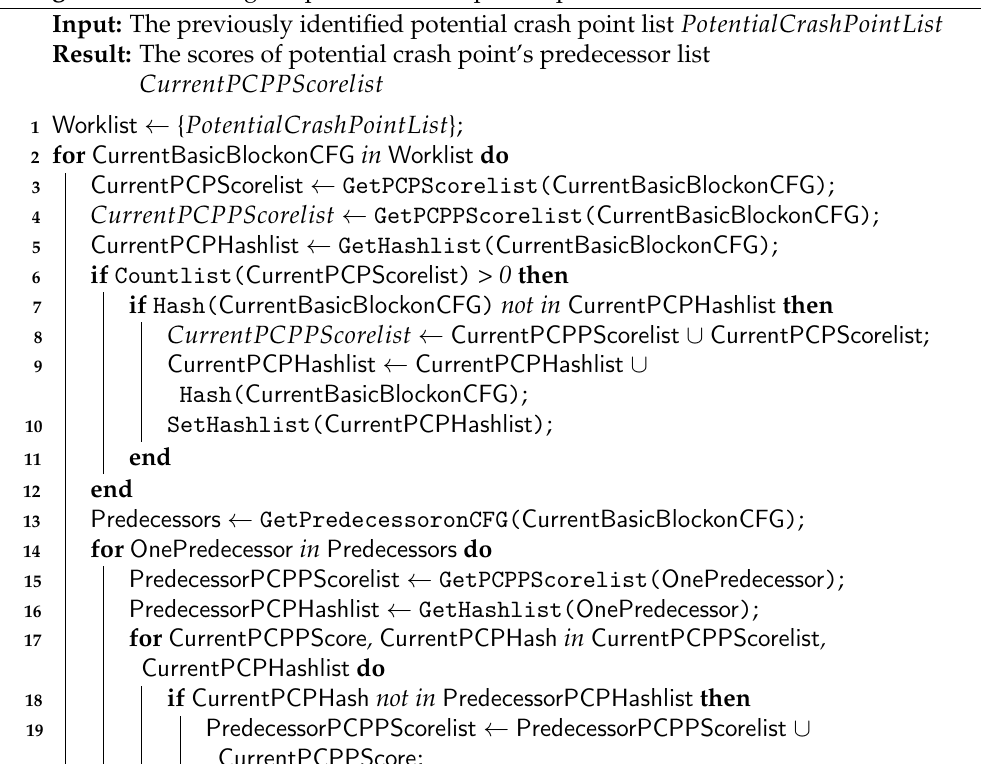
Algorithm 2: Scoring the potential crash point’s predecessor.